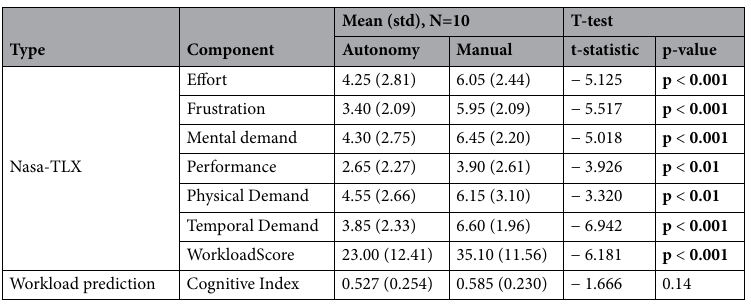
Table 3. Nasa-TLX results and measured cognitive workload. Statistically significant results ( α = 0.05 ) were highlighted in bold. The NASA-TLX is a 10-point Likert scale questionnaire that divides the workload demands into 6 components: effort, frustration, mental demand, performance, physical demand, and temporal